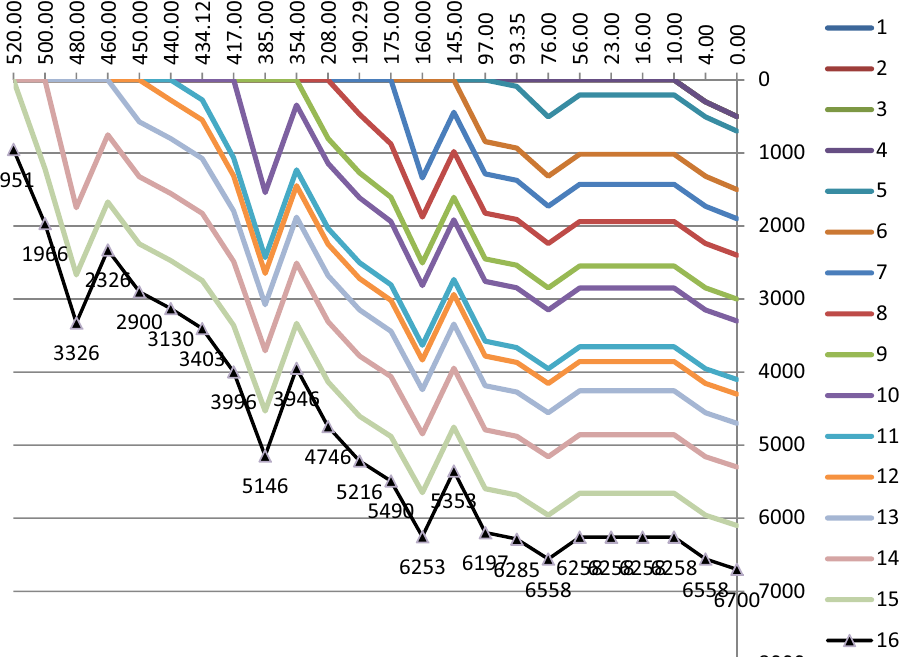
Fig. 4 Curve chart of burial